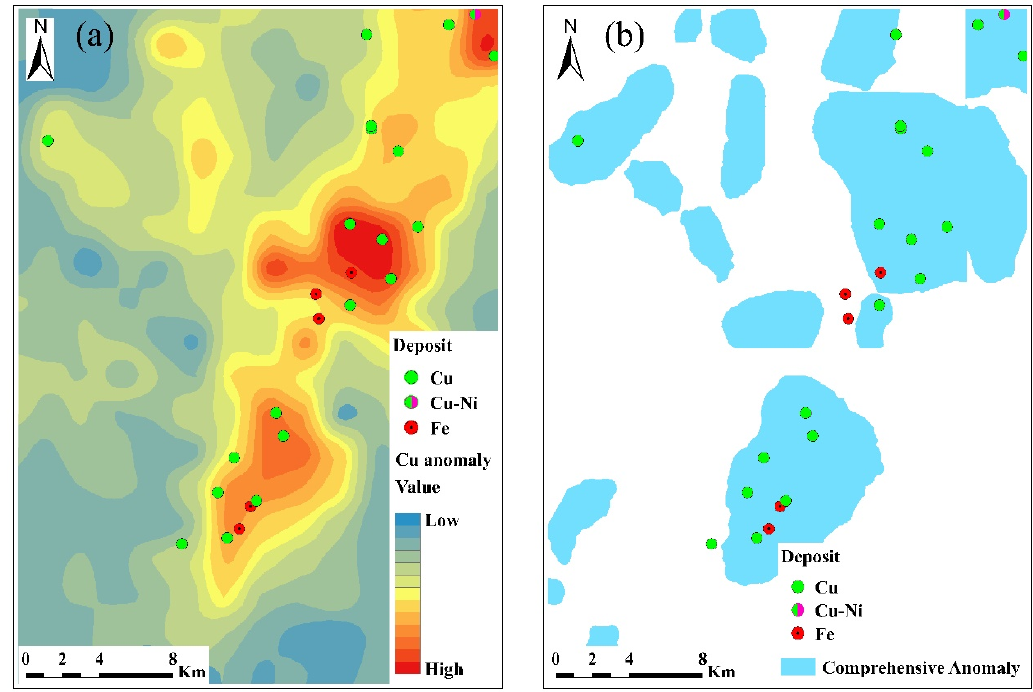
Figure 7. ( a ) Map of Cu anomalies; ( b ) map of comprehensive anomalies.